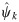
Classifying grid cells with the spike-based and the correlogram-based grid score.a) Venn diagram of 619 recordings from cells in mEC. Different colors highlight areas with different classification results (classification by Ψ and/or ρ score positive/negative). See text for a description of the classification method. b) Correlation of Ψ and ρ score as in Fig 3e. Markers represent the classification of the cell using the color code and the symbols from a. c, d, e, f, g) Individual recordings in different classification categories. The category is indicated by the marker on the left, using the scheme in a. From left to right: spike map with each spike k color-coded with its grid score ψ^k (global Ψ score shown above); smoothed spike density (“rate map”), brighter values indicate higher density of spikes; autocorrelogram of the rate map (ρ score shown above); smoothed histogram of pairwise distances of all spikes, dashed orange lines show automatically detected neighborhood shells. See text for a detailed description of all examples. Experimental data recorded and made publicly available by Sargolini et al. [6] through [16].